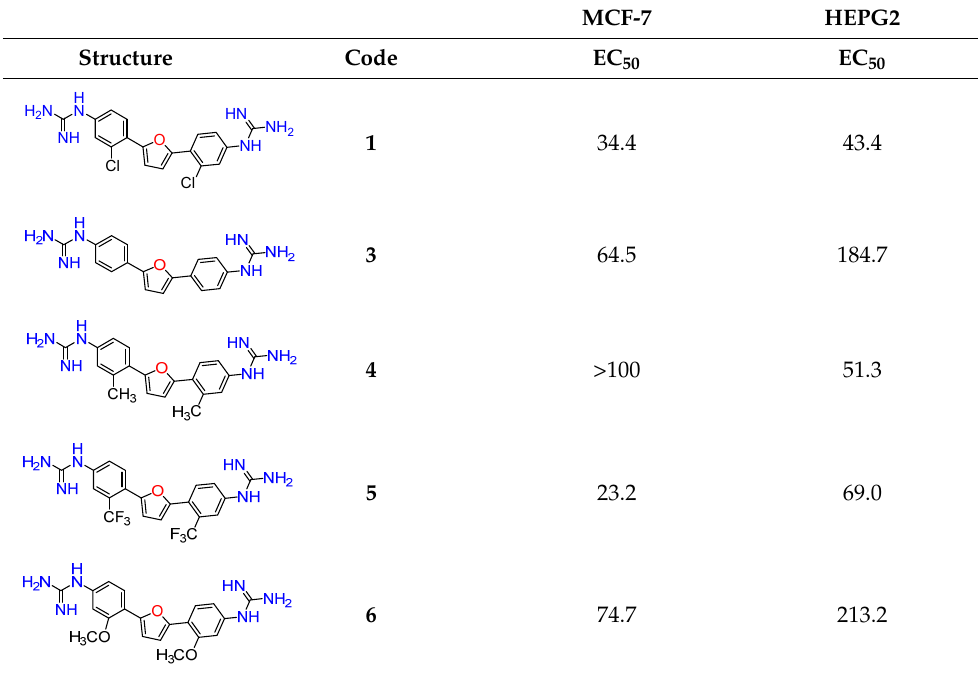
Table 1. Cytotoxicity of each compound against MCF-7 and HepG2 human cell lines.